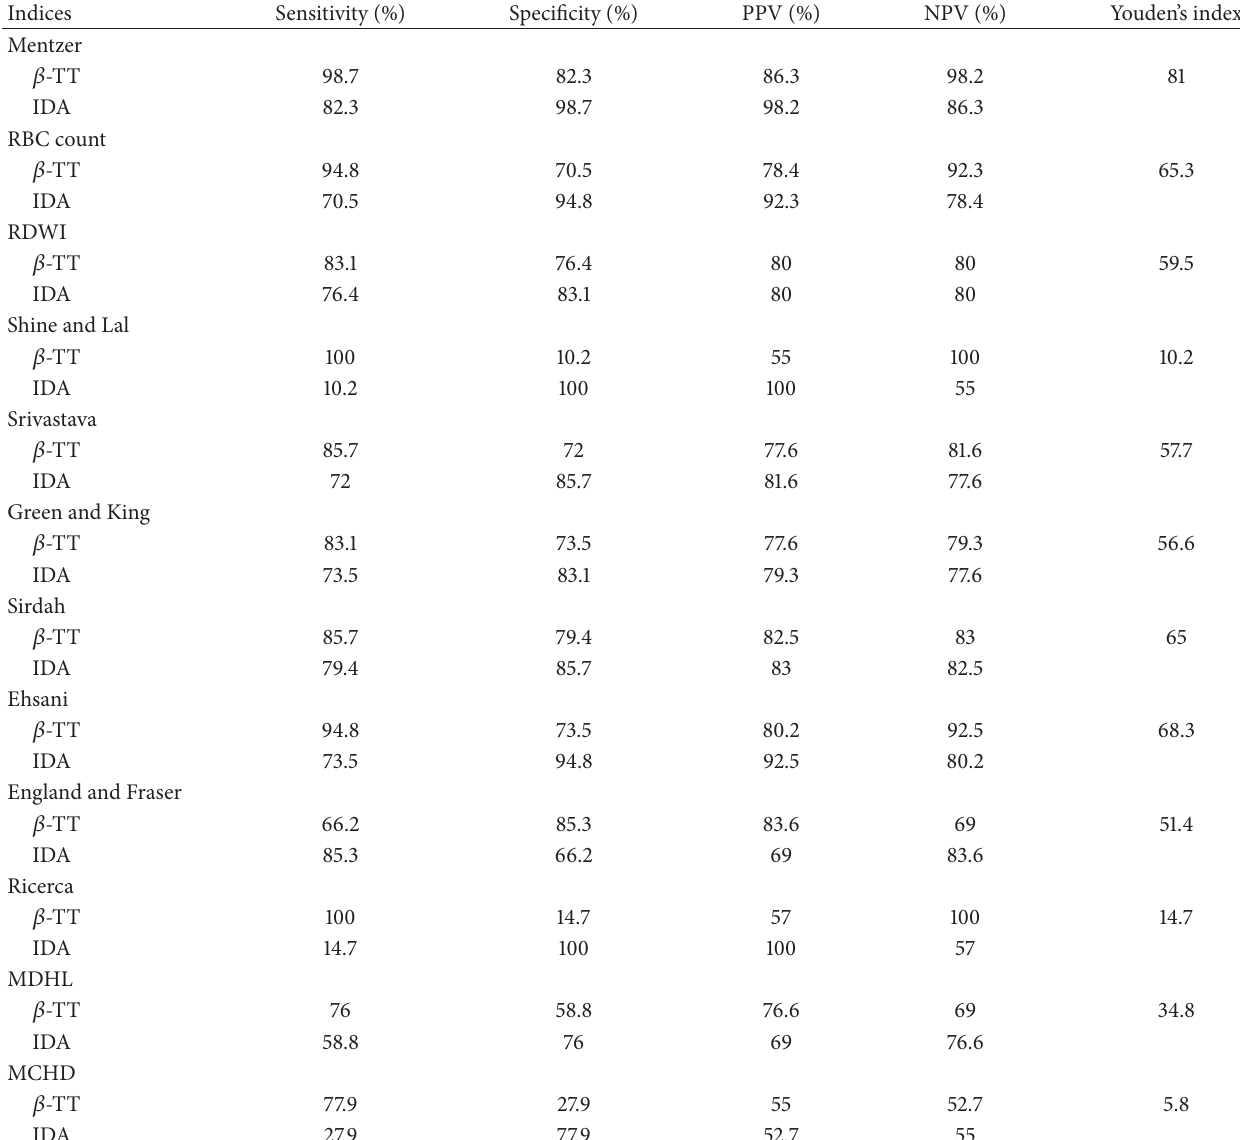
Table 4: Sensitivity, specificity, positive predictive value (PPV), negative predictive value (NPV), and Youden’s index of twelve indices to discriminate between 𝛽 -TT and IDA in 290